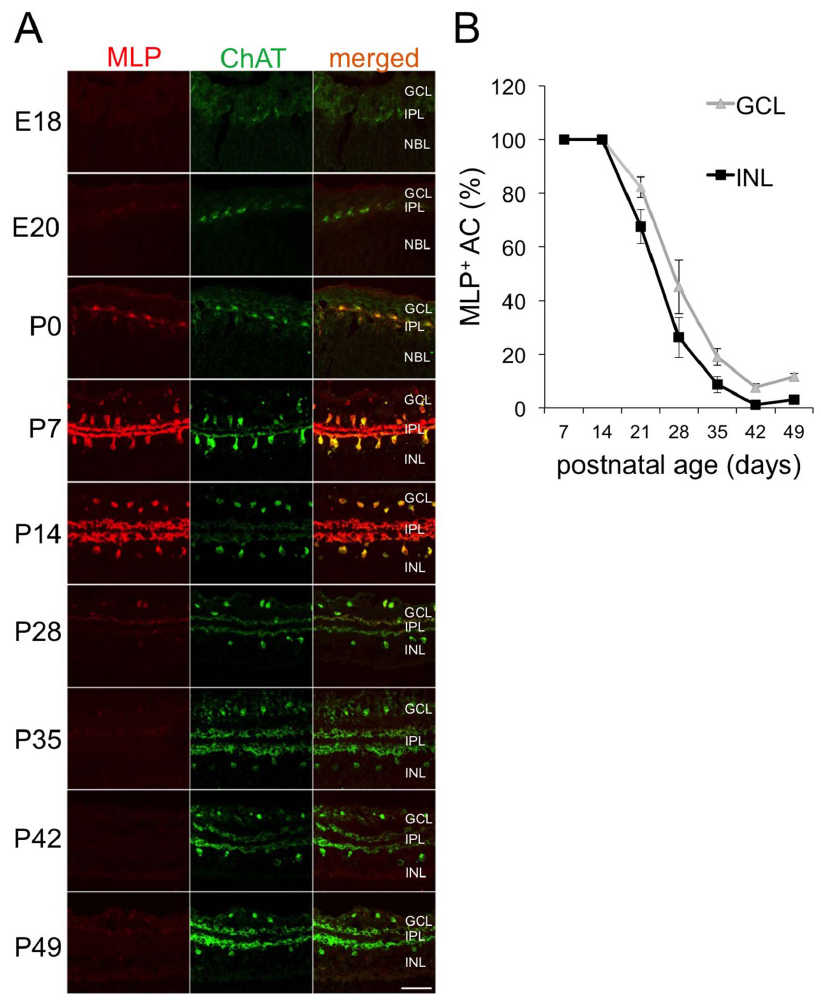
Figure 2. Expression of MLP in postnatal ChAT-positive AC. A : Confocal images were taken of E18, E20, P0, P7, P14, P28, P35, P42 and P49 retinae after co-staining with antibodies against ChAT and MLP. MLP expression becomes detectable at E20 in ChAT-positive AC located in the inner nuclear layer as well as ganglion cell layer. Levels reached a peak between P7 and P14. MLP expression dramatically decreases afterwards. GCL=ganglion cell layer, IPL=inner plexiform layer, INL=inner nuclear layer Scale bar: 50 m m. B : Quantification of MLP-positive cholinergic AC in the inner nuclear layer (INL) and ganglion cell layer (GCL, displaced) of retinae of 7–49 days old rats. All cholinergic AC were positive for MLP at P7 and P14. Numbers of MLP-positive AC continuously decreased between P21 and P42. This attenuation proceeded slightly faster in the INL than in the GCL. ferred to polyvinylidene fluoride (PVDF) membranes (Bio-Rad). The blots were blocked in 5% dried milk with 1% bovine serum albumin (BSA) in Tris-buffered saline-Tween-20 and processed for immunostaining with either a polyclonal antibody against MLP (C9001-23; United States Biological; 1:500) or a monoclonal antibody against b -actin (AC-15; Sigma; 1:5000). Bound anti- MLP-antibody was visualized with anti-goat immunoglobulin G (IgG) secondary antibody conjugated to horseradish peroxidase (Sigma, 1:30 000) and the antigen–antibody complexes were detected by enhanced chemiluminescence (Bio-Rad). Bound anti- actin-antibody was visualized with anti-mouse infrared dye secondary antibody (IRDey 800 CW; LI-COR; 1:20 000) using Odyssey Infrared Imaging System (LI-COR).